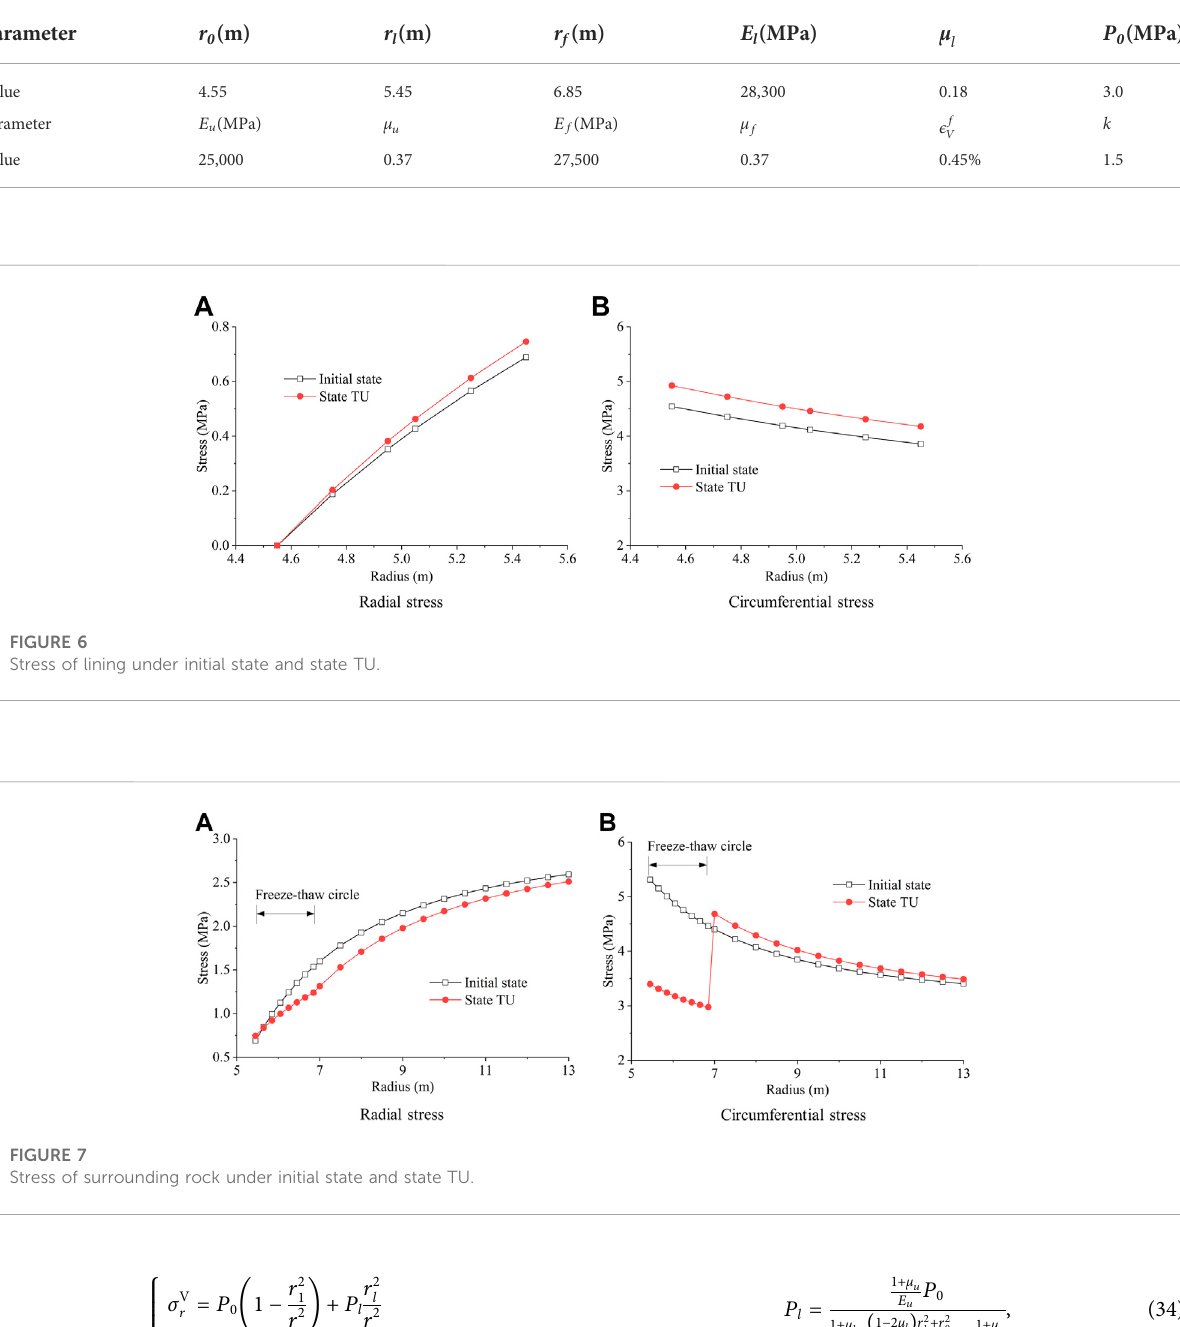
TABLE 1 Parameters of the section K105+785 in the cold region tunnel.